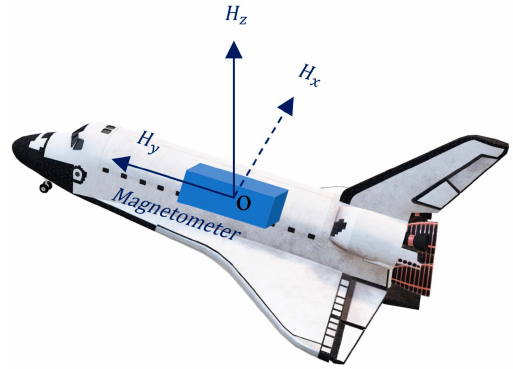
Figure 1. The magnetometer frame on a